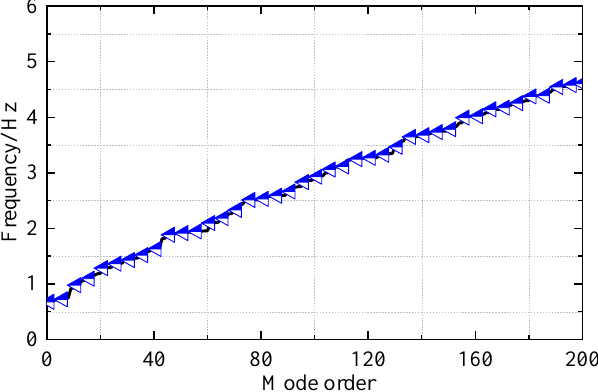
Figure 13. Natural frequency distribution of the cooling tower.